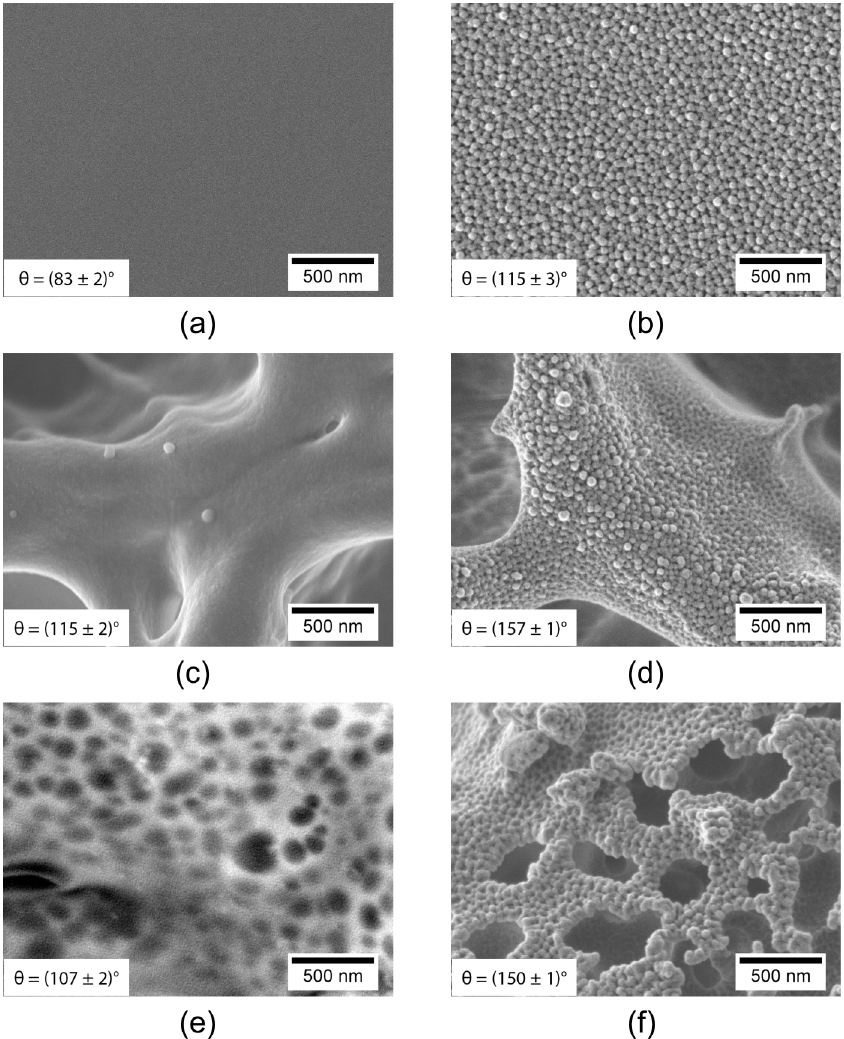
Figure 4. The effect of plasma etching on different types of PS substrate and the corresponding water contact angle: ( a ) flat PS; ( b ) CF 4 plasma-treated flat PS; ( c ) porous PS with a smooth border; ( d ) CF 4 plasma-treated porous PS with a smooth border; ( e ) porous PS with a porous border; ( f ) CF 4 plasma-treated porous PS with a porous border. The images represent SEM micrographs. The smooth borders were prepared using five doses of 1.5 THF:8.5 ETH at 295 K. The porous borders were